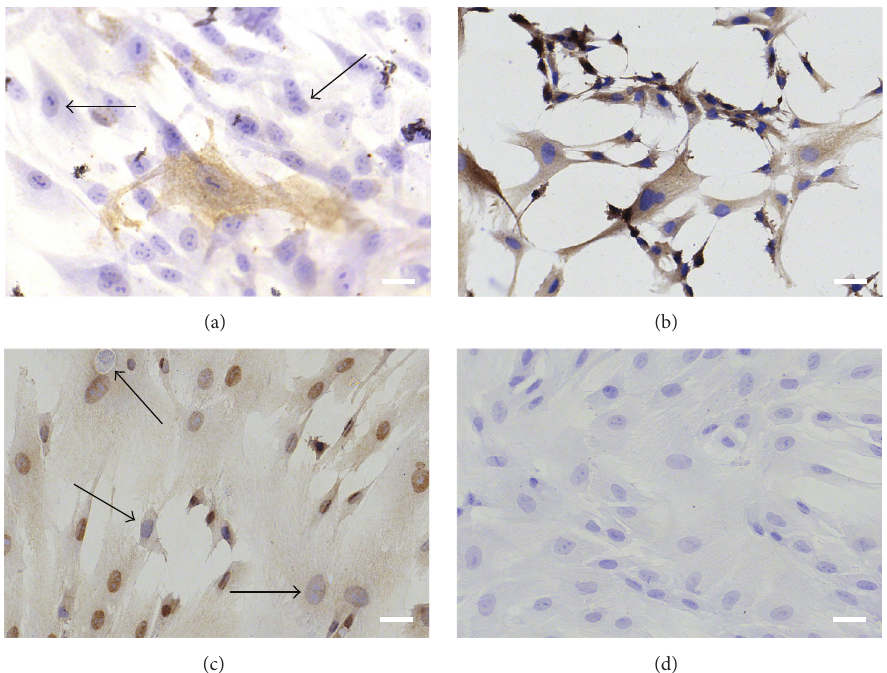
Figure 7: Staining of WJ-MSCs in culture for (a) 𝛼 SMA, (b) ALDH1A1, and (c) Oct4 expression. (d) Representative control staining without primary antibody. All cells stain positive (brown) for ALDH1A1, but not for 𝛼 SMA and Oct4 (black arrows), indicating that a heterogeneous cell isolate was obtained. Scale bars = 50 𝜇 m. Representative images of at least 3 donors are shown.